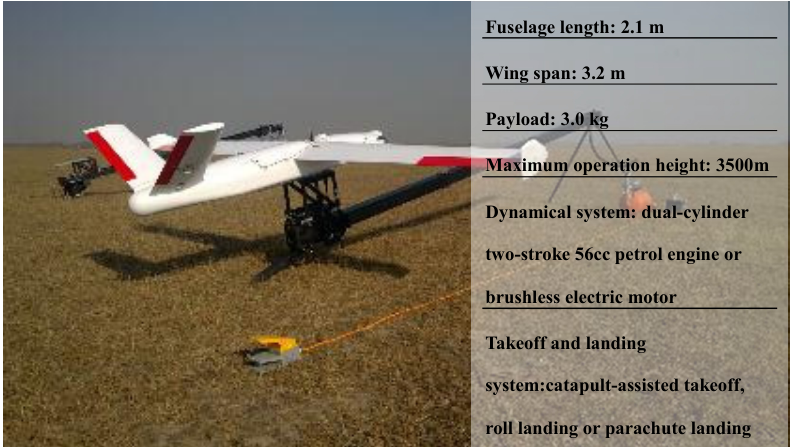
Figure 10. Diagram of fixed wing UAV.